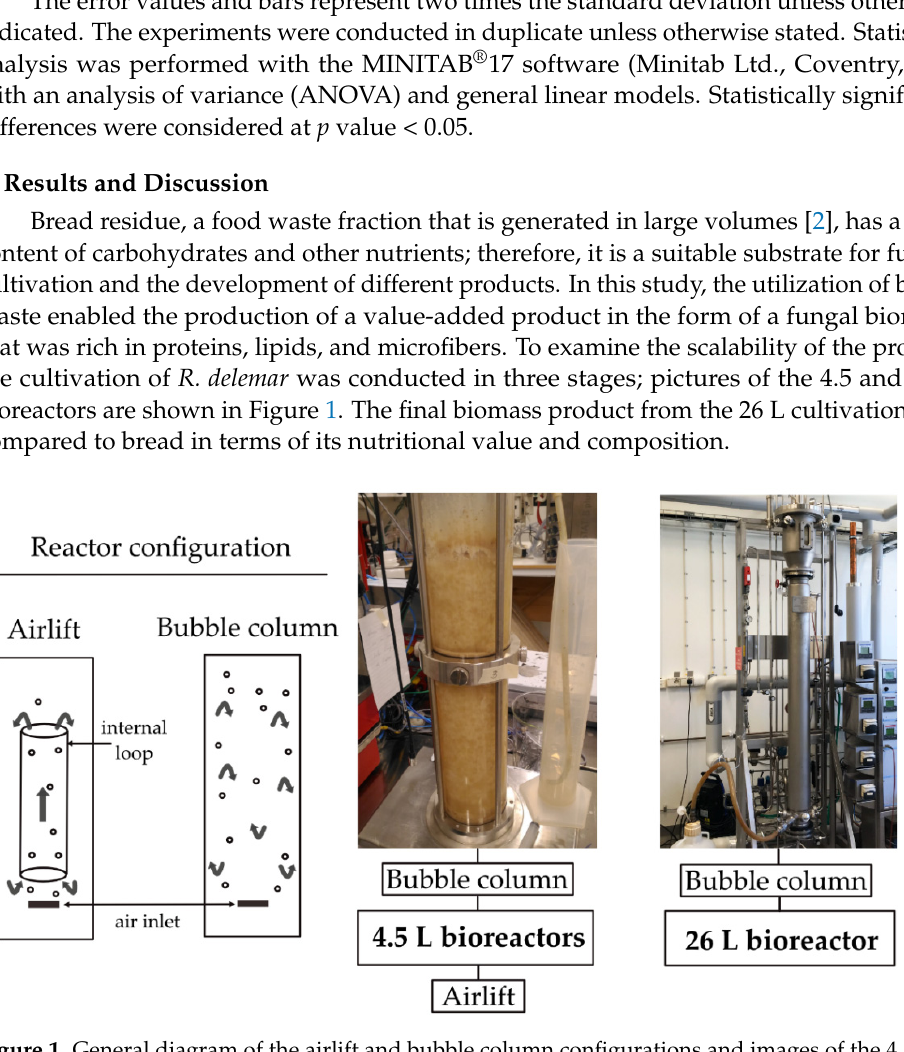
Figure 1. General diagram of the airlift and bubble column configurations and images of the 4.5 and 26 L bioreactors.